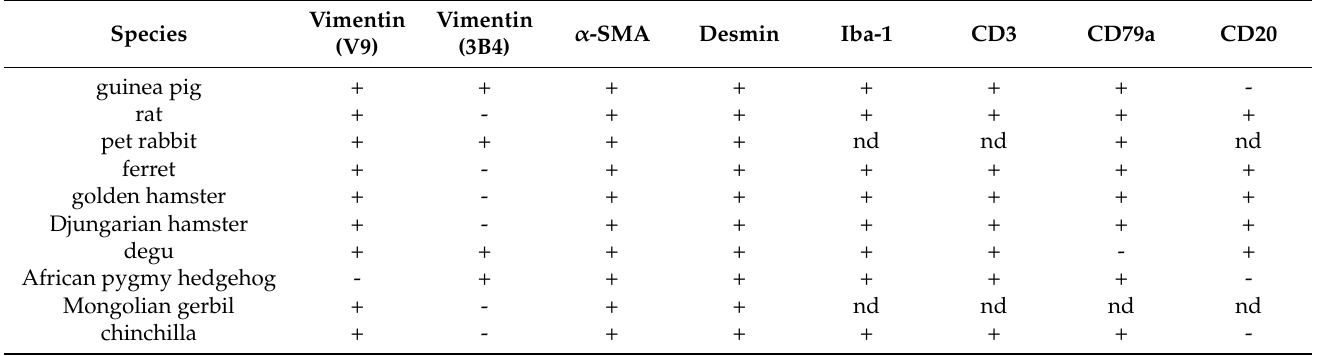
Table 2. Immunoreactivity of primary antibodies in control tissues of small mammal pets (“+” in- dicates that there was a positive reaction in control tissues; “-” indicates that there was lack of any reaction in control tissues; and “nd” indicates that the investigation was not performed due to either a lack of the appropriate control tissue or a lack of the appropriate primary